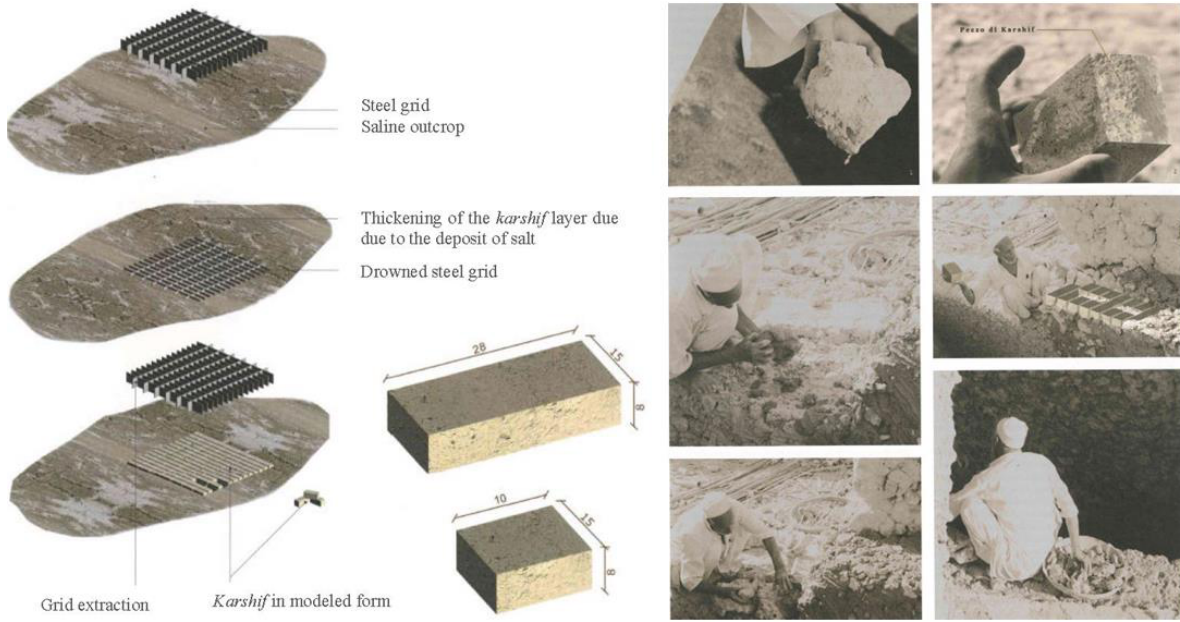
Figure 11. Technological upgrading: the method for crystallization of karshif within special wooden grids (drawings courtesy of the following authors: Calvano S., Loconte P., Pizzolante S., Ricupero P. and Vitulli